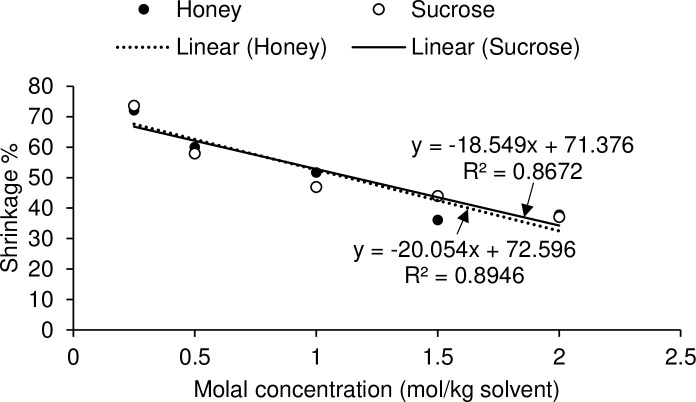
Relationship between molal concentrations of honey and sucrose, and ooplasm shrinkage at 60 s during dehydration phase (n = 3 oocytes per treatment group per replicate × 3 replicates).